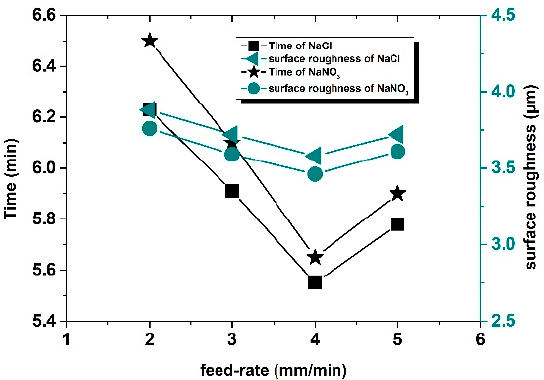
Figure 14. Roughness and machining time of feed rates in different electrolyte solutions on machin- ing results.